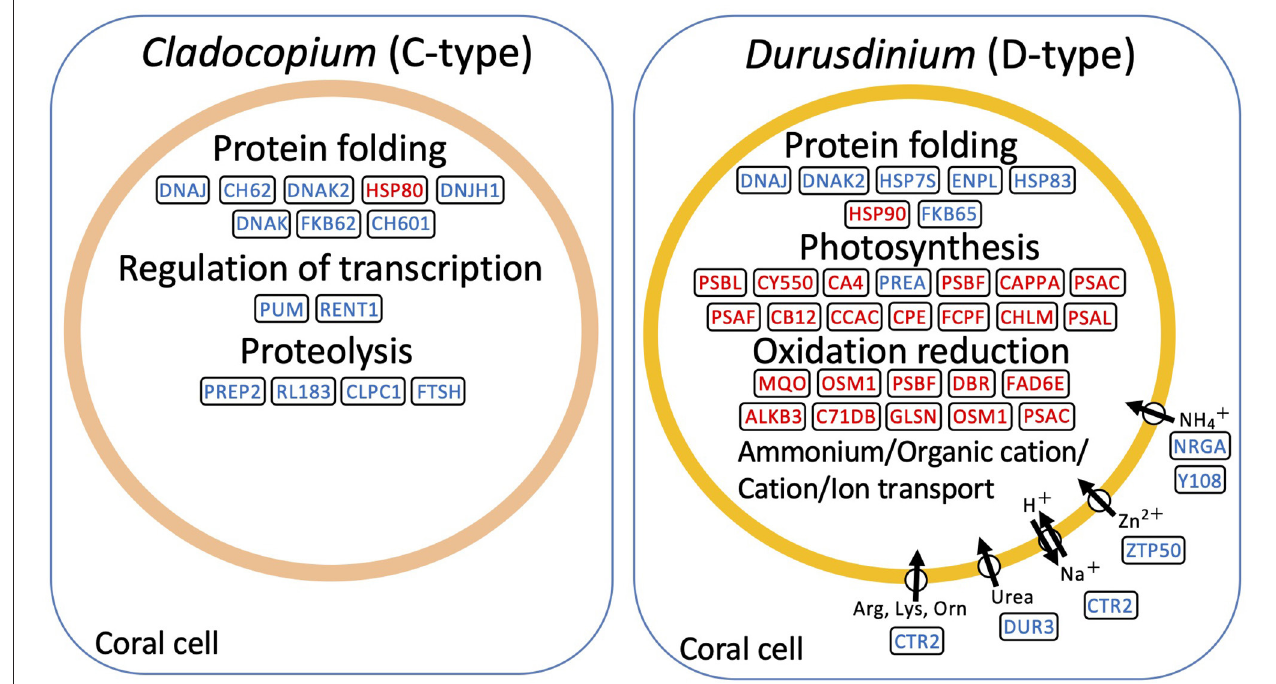
FIGURE 6 | Schematic presentation of representative genes involved in high temperature and strong light stress based on RNA-seq data of symbiont, Cladpcopium (C-type) and Durusdinium (D-type). The representative enriched GO and their related genes were shown. Upregulated transcripts during bleaching are shown in red; downregulated transcripts are indicated in